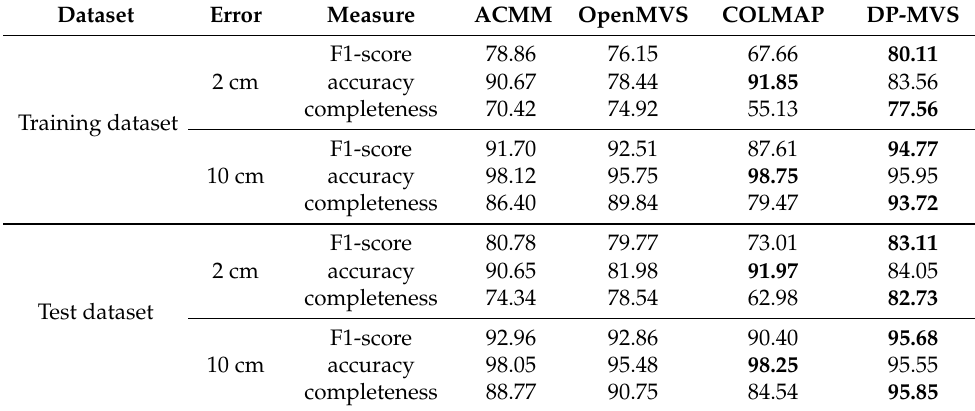
Table 2. Evaluation on high resolution multi-view datasets of ETH3D benchmark. It shows F1-score, accuracy and completeness at different error levels (2 cm and 10 cm), with bold format highlighting the best evaluation among all the methods including ACMM [50], OpenMVS [56], COLMAP [26] and DP-MVS.